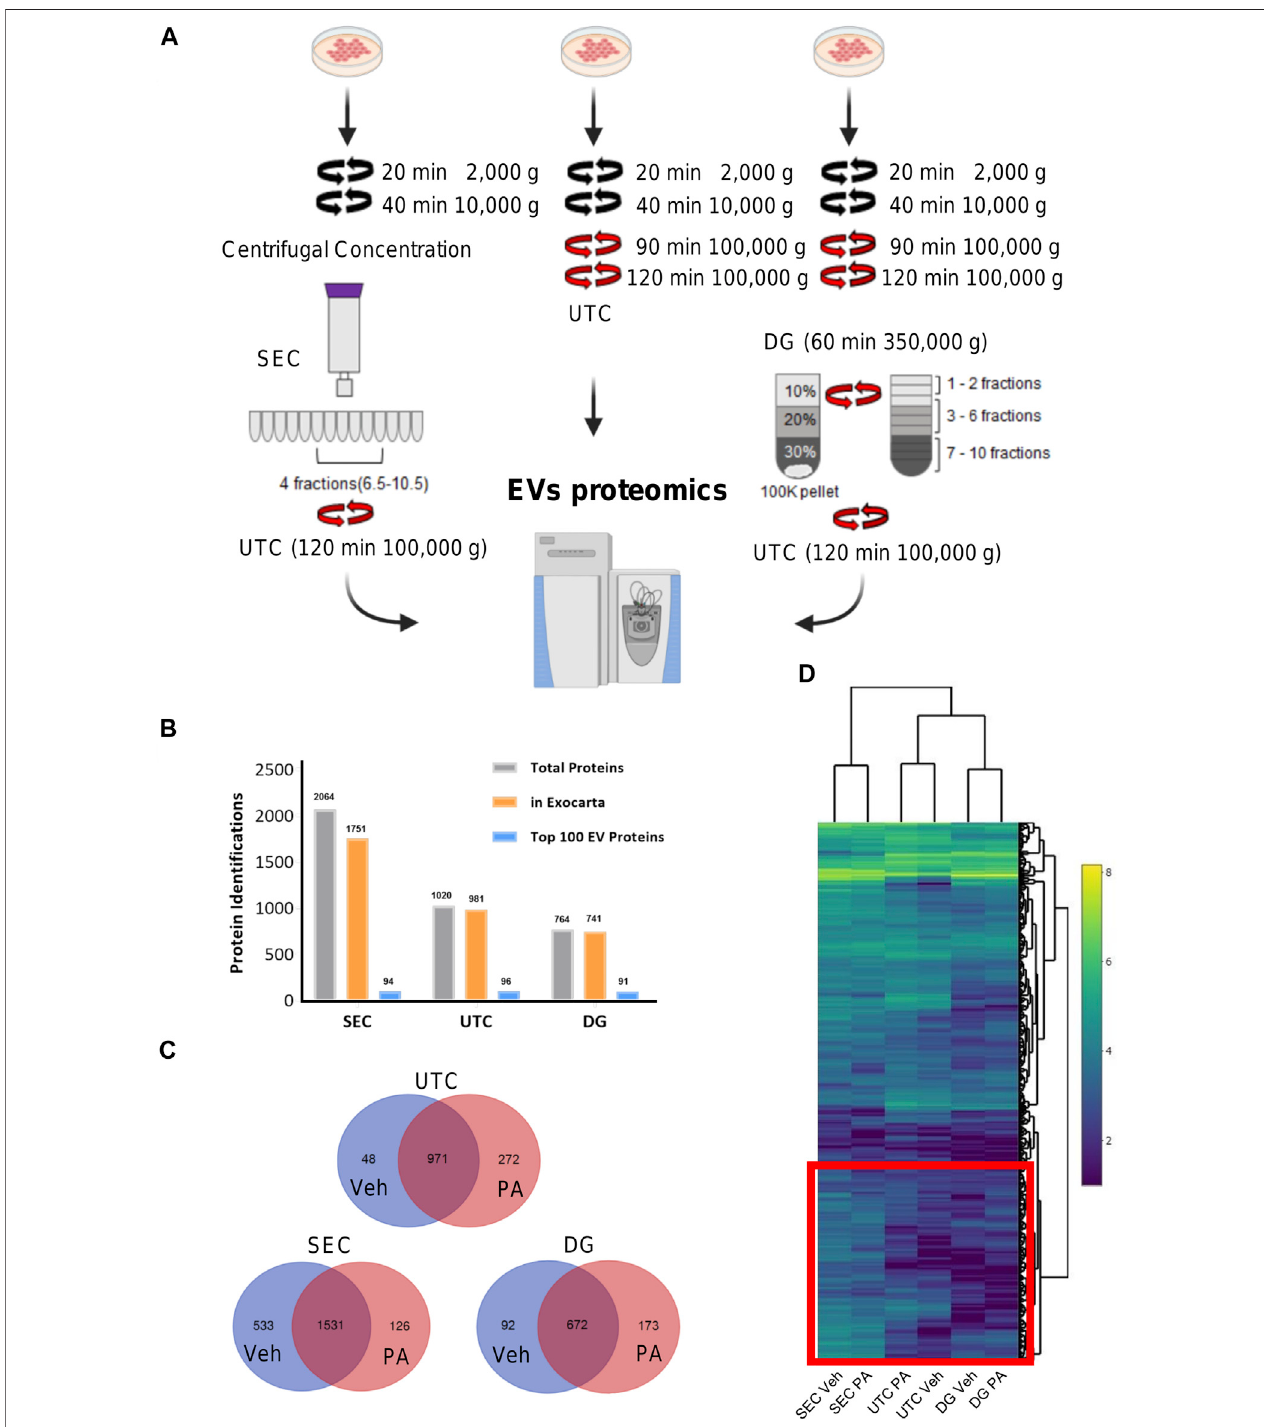
FIGURE 1 | Overview of EV proteomics methods. (A) Schema represents three extracellular vesicle (EV) isolation methods for EV proteomics. In size exclusion chromatography (SEC) methods, fractions 6.5 to 10.5 were combined and pelleted by ultracentrifugation (UTC). For the UTC sample, the 100,000 × g fraction was utilized. For Iodixanol, density gradient (DG) fractions 1 – 2, 3 – 6, and 7 – 10 were collected and combined. (B) The number of identi fi ed proteins for each of the three methods, SEC, UTC, and DG. The gray bars display the total number of identi fi ed proteins, the orange bars display the number of the total protein IDs that were found in the ExoCarta database, and the blue bars display the number of proteins from each method that was found in the ExoCarta top 100 EV proteins. (C) Venn diagrams depicting the number of unique proteins that were detected in vehicle (Veh) or palmitate (PA) stimulated EVs by each method. (D) Heatmap shows common 537 proteins that were detected by each method. Heatmap color represents Log2 protein abundances. The red box encloses the cluster of proteins with higher abundance in EVs isolated by SEC.